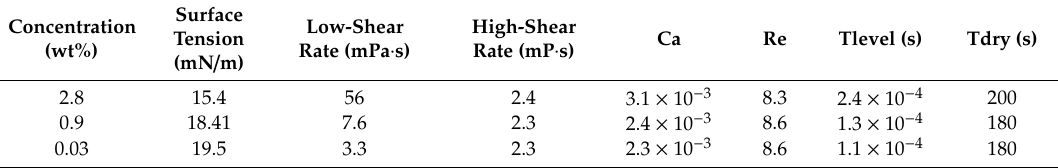
Table 1. Optimized condition of surface tension and viscosity with di ff erent concentration of Cu nanoplate (NPL)